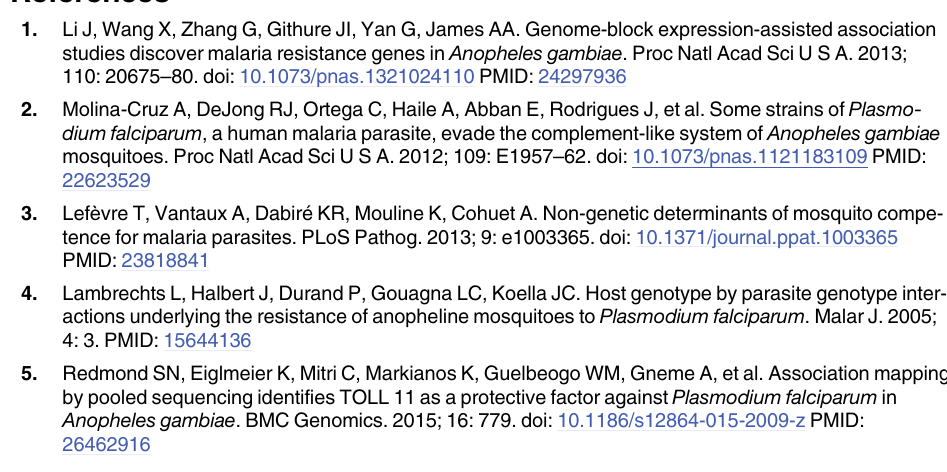
S1 Table. Details of sample size, Infection rate and intensity in experiment 1. S2 Table. Details of sample size, Infection rate and intensity in experiment 2. S3 Table. Risk of mosquito mortality (hazard ratio) along with the 95%CI, z, P-value and sample size for each treatment group relative to the 5% glucose